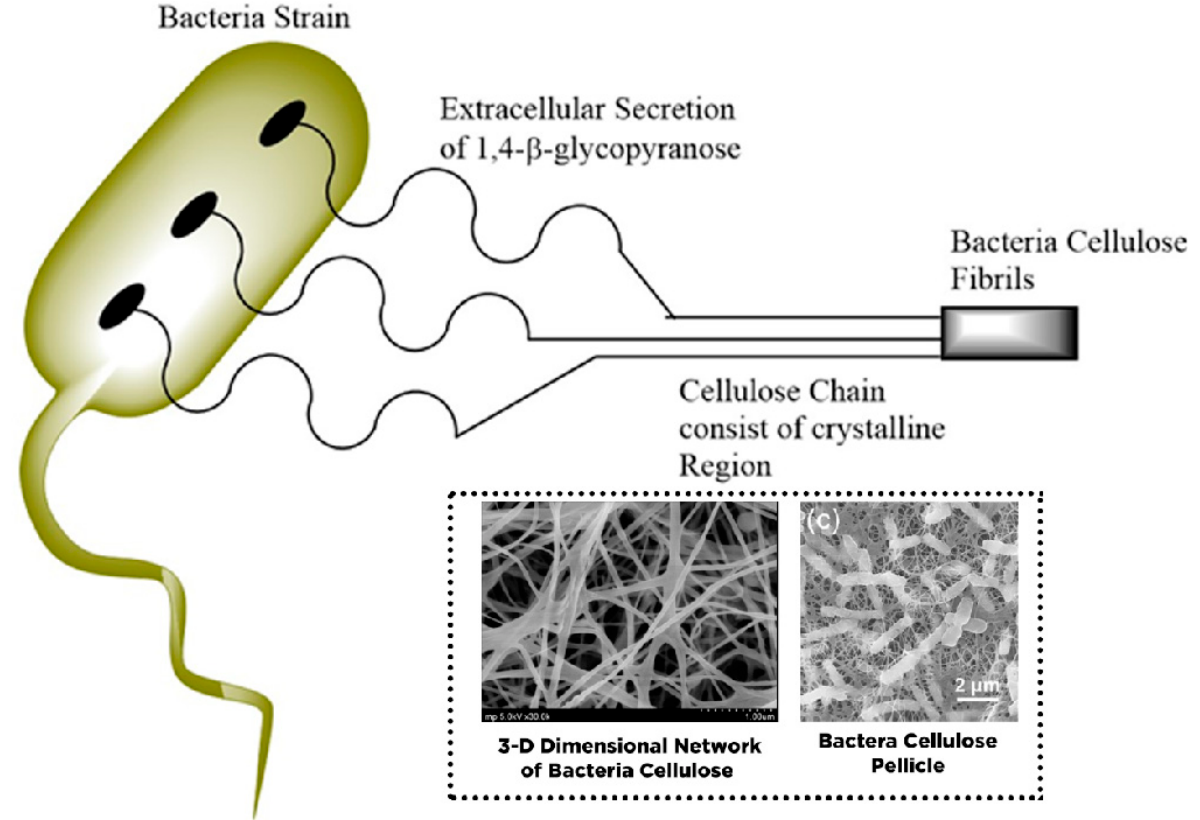
Figure 5. Schematic production of bacteria cellulose through extracellular secretion (scanning electron microscopy (SEM) images of 3-D dimensional network of bacteria cellulose [58], reprinted with permission; ( c ) scanning electron microscopy (TEM) images bacteria cellulose pellicle, reprinted with permission from ref. [59]. Copyright © 2019 Elsevier Ltd.)